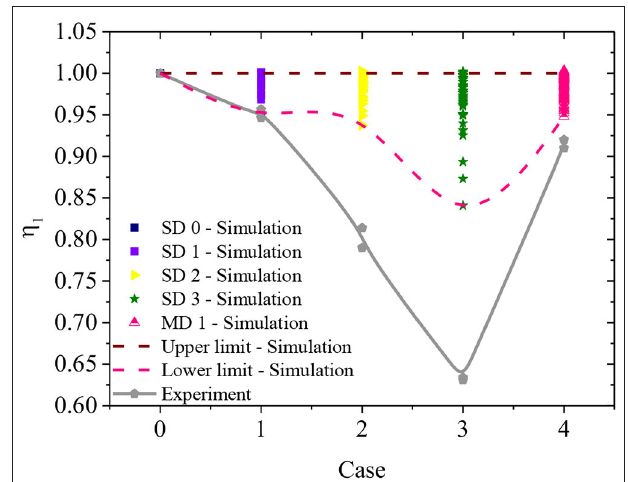
FIGURE 4 | Numerical and experimental